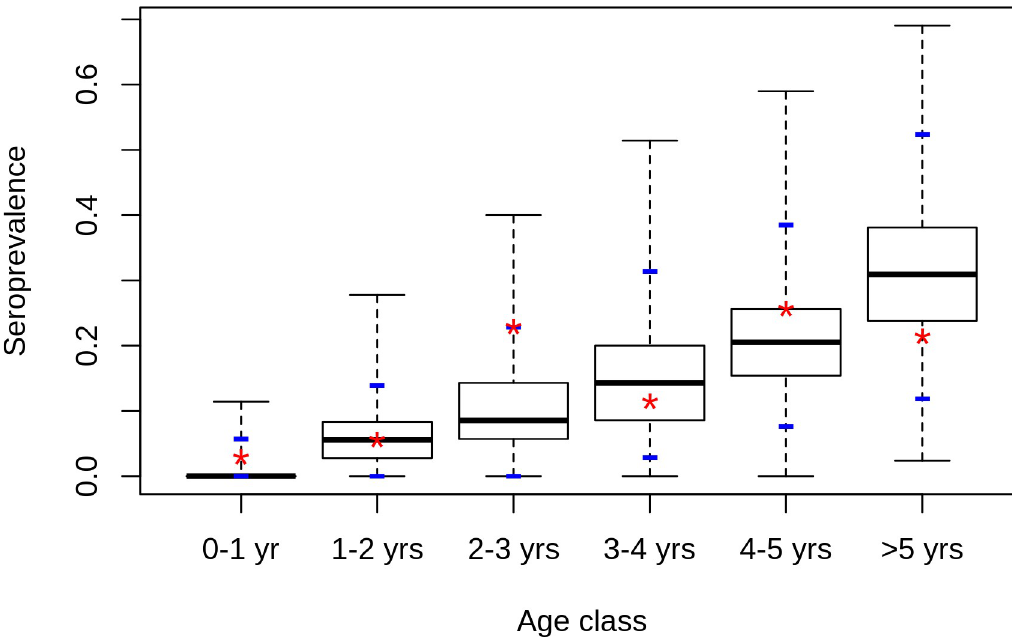
Fig 3. Predicted distribution of seroprevalence rate by age class in sedentary small ruminants. Model is model M4 which combines direct transmission between hosts but no VT in Aedes, and repeated introductions of RVFV by viraemic nomadic animals, each rainy season, from 2008 to 2015. Stars: observed values, blue dashes: 2.5% and 97.5% percentiles of predicted distributions.